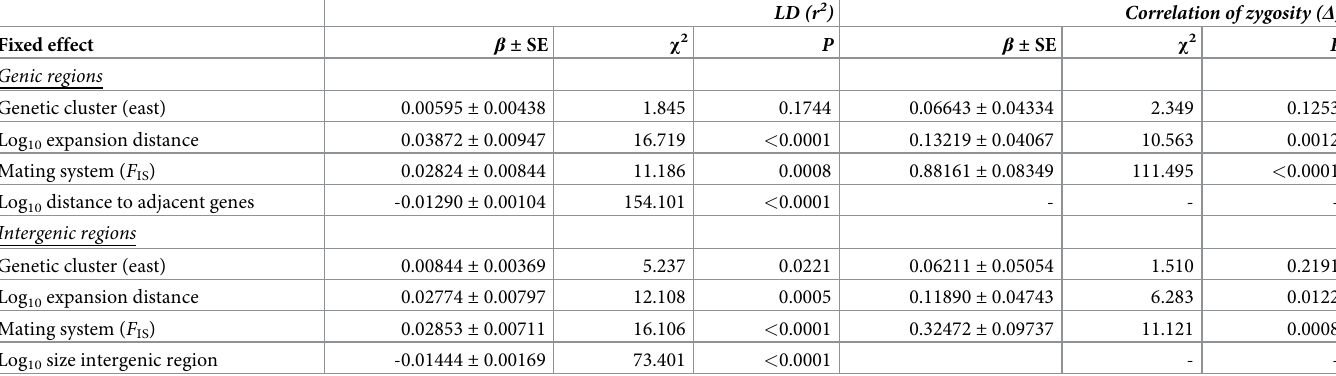
Table 1. Results of the linear mixed-effects models on genome-wide linkage disequilibrium (LD, distance-corrected r 2 between pairs of SNPs) or the correlation of zygosity ( Δ ) of genic regions and (top) intergenic regions (bottom). For each fixed effect, the model estimate ( β ) as well as the chi-square statistics ( χ 2 ) with the associ- ated p value from type III Wald χ 2 tests are given. For the correlation of zygosity, the results for Δ at 1000 bps distance are shown (see also S7 Fig). Only results for fixed effects are shown. LD (r 2